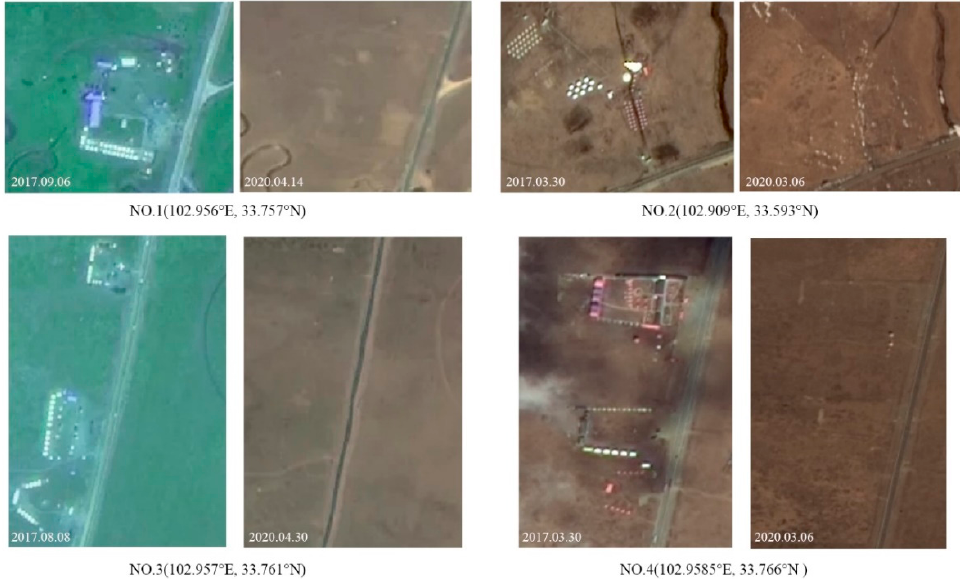
Figure 5. Comparison of remote-sensing images of demolition points of typical illegal facilities (high-resolution remote-sensing images from Chinese GF-1 and GF-2 satellites).